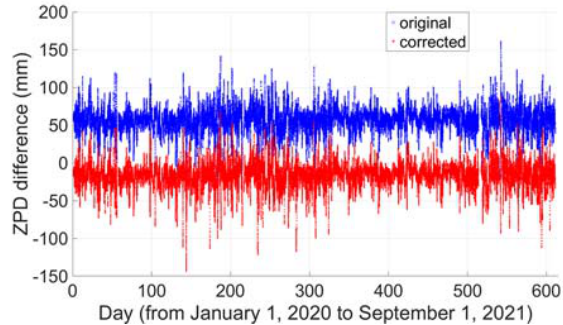
Figure 12. ZPD difference between BRUX and REDU.